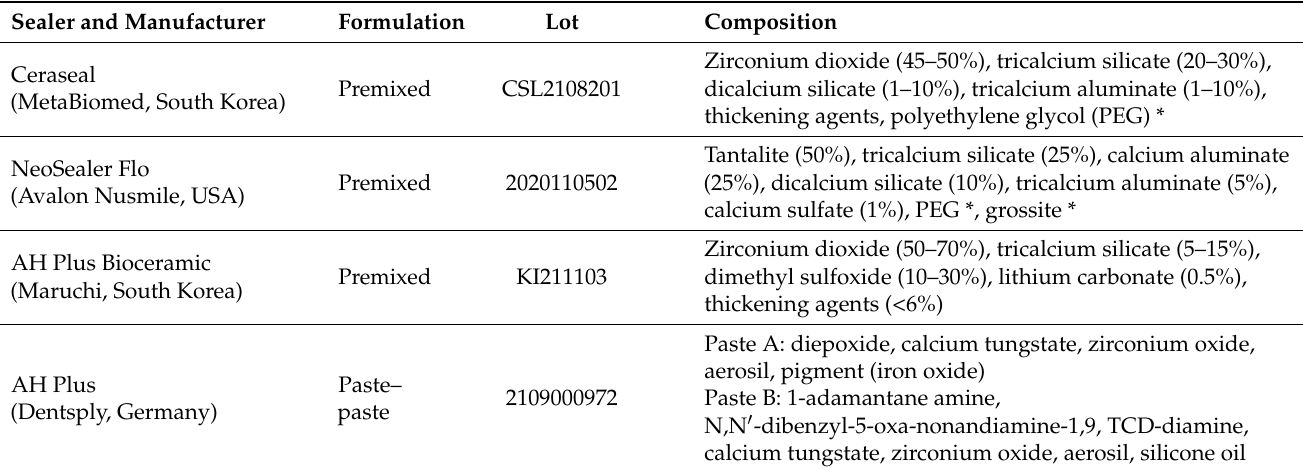
Table 6. Sealer formulation, lot and composition in accordance with manufacturer Safety Data Sheet. Asterisk (*) indicates the components detected by our